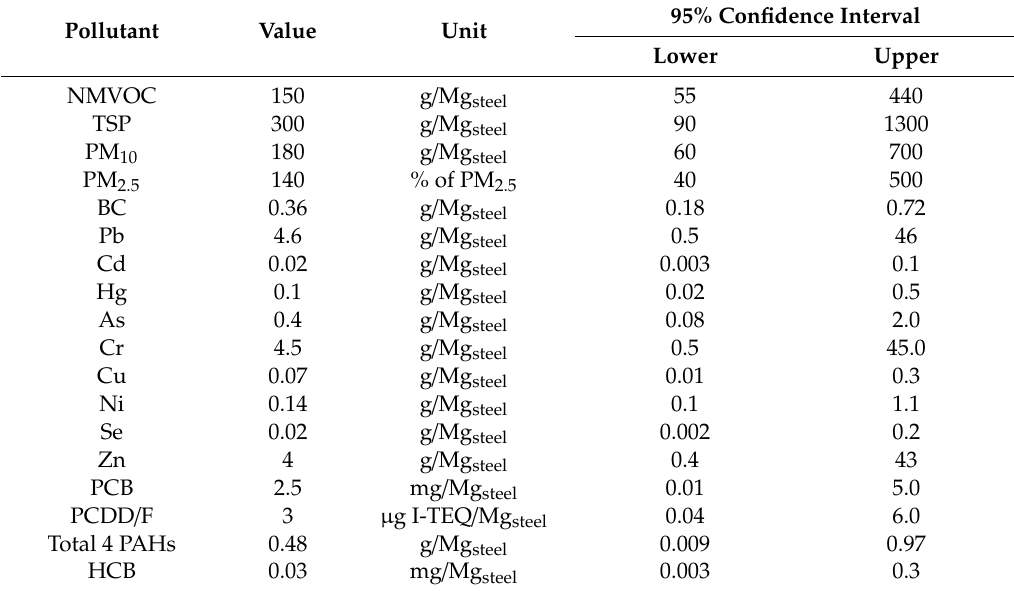
Table 1. Steelmill specific air emissions of heavy metals and organic compounds, sector averages and spreads